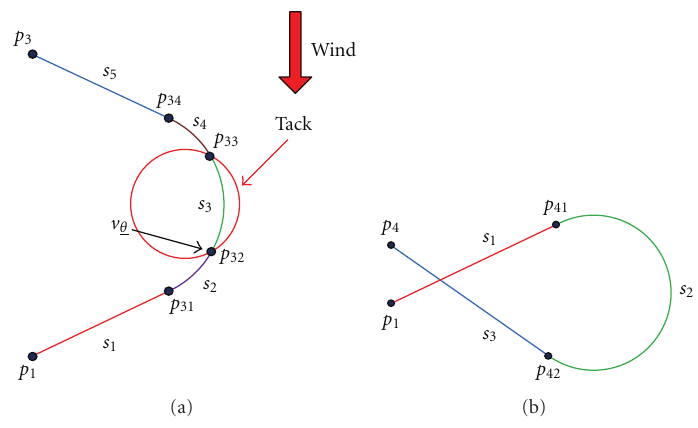
Figure 4: Desired path for (a) tacking and (b)